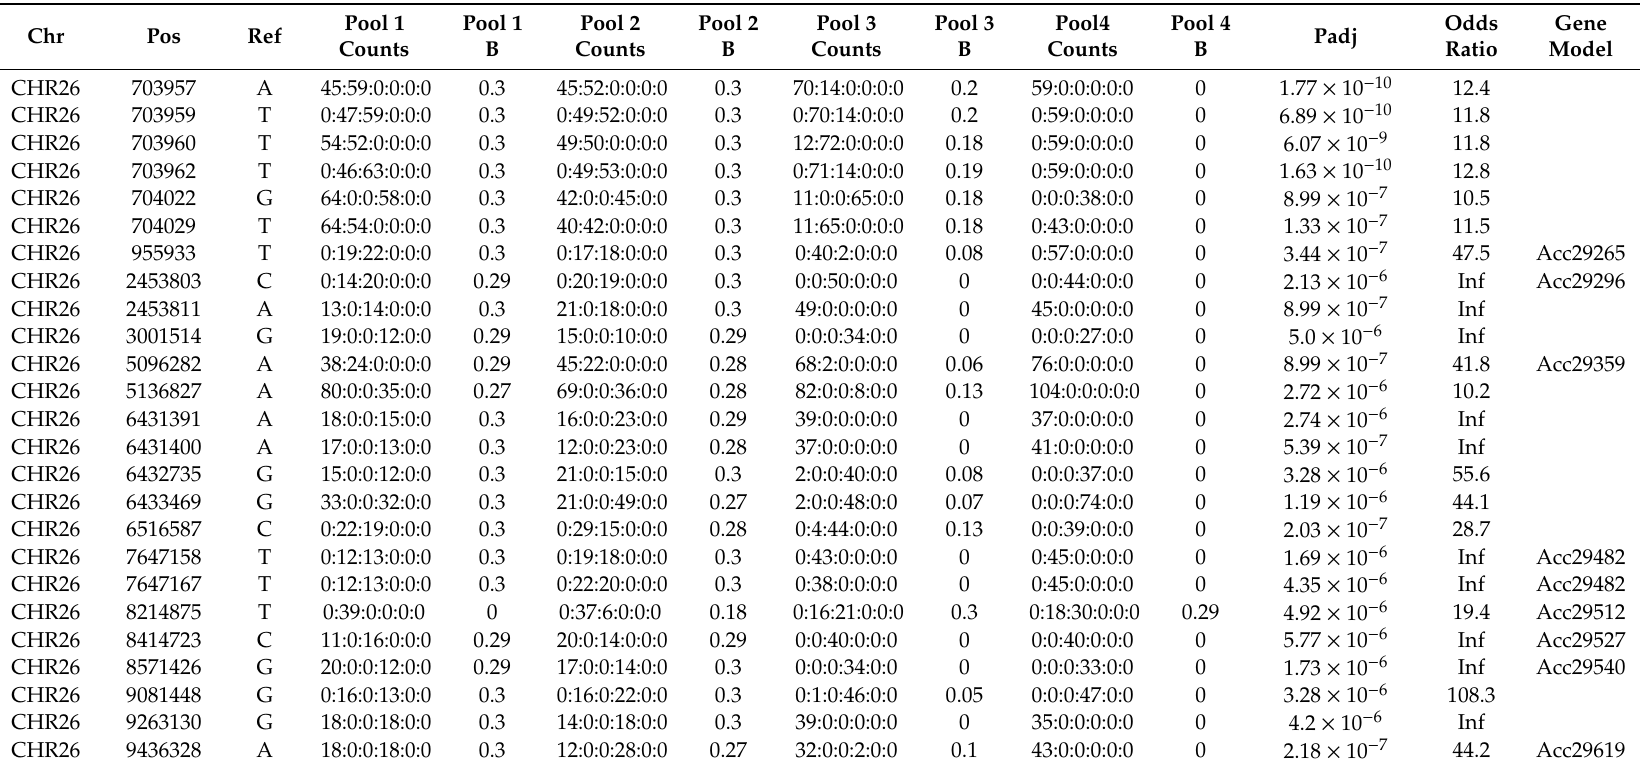
Table A1. Positions on the ‘Red5’ version PS1.68.5 assembly and allele counts of SNP loci exhibiting significant association with fruit AsA level by CMH tests with adjusted p -value < 10 − 6 . Allele counts at SNP loci were normalised by resampling to 40 reads and are in the format A:T:C:G:N:del. B denotes Ewens homozygosity information